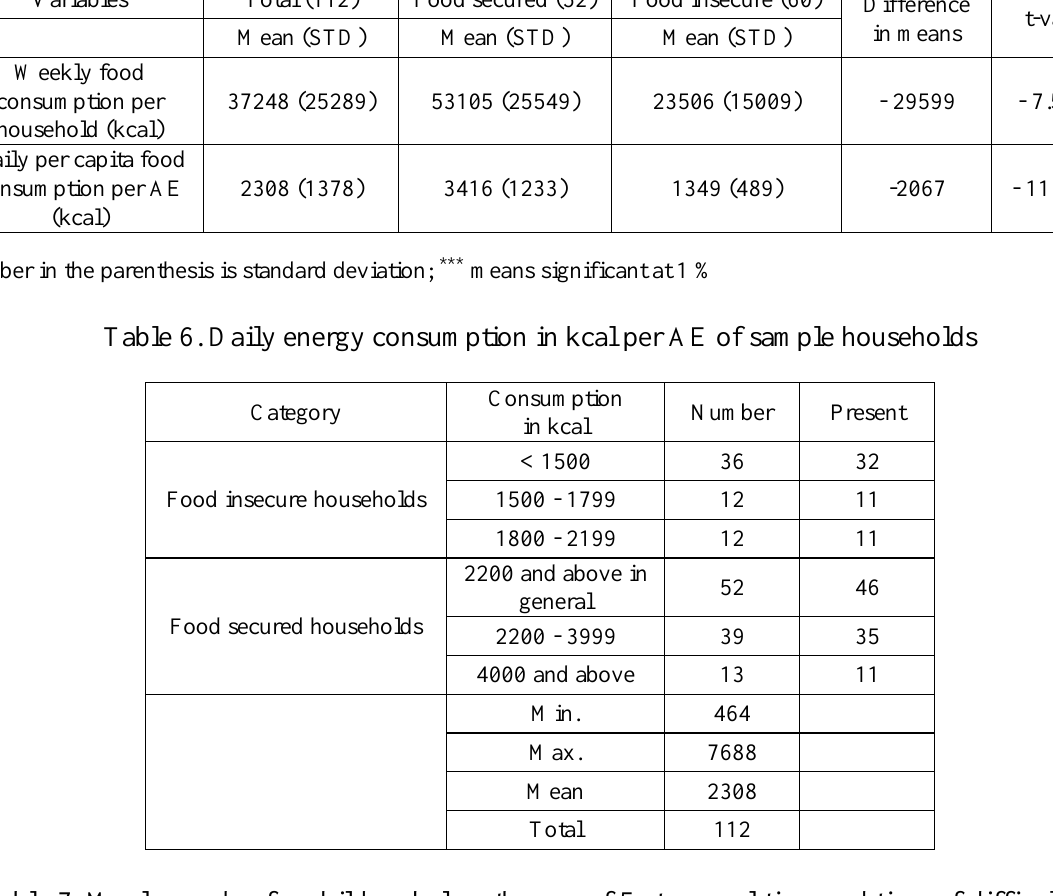
Table 7. Meals per day for children below the age of 5 at normal time and time of difficulties